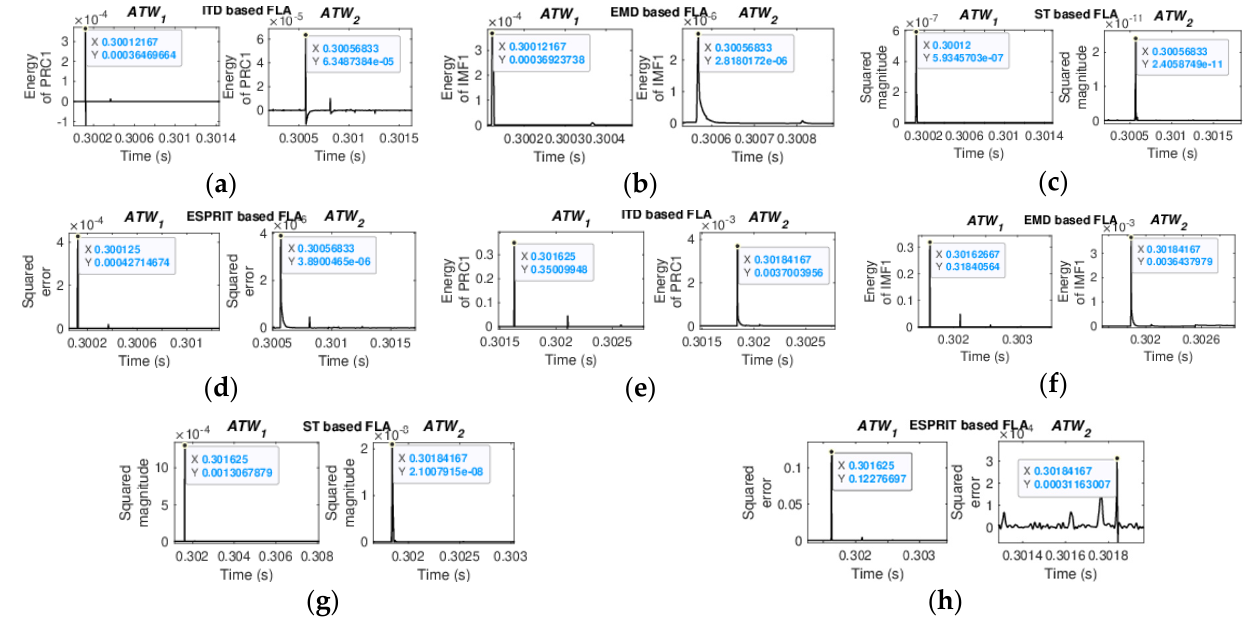
Figure 6. Estimation of ATWs for shunt-compensated systems for faults before STATCOM. ( a – d )